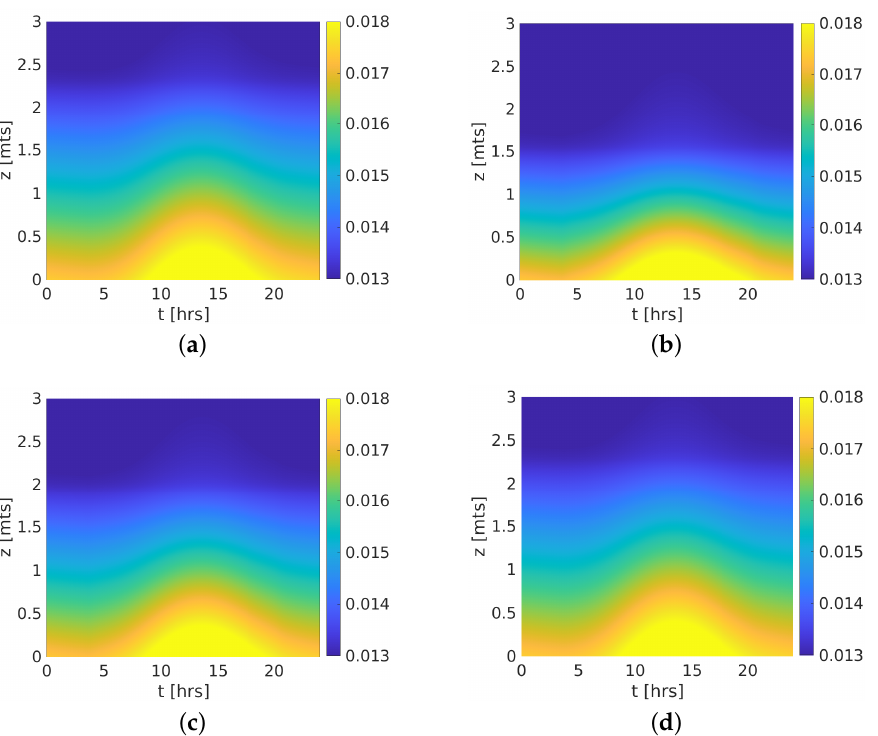
Figure 6. Leaf humidity at 24 h for all canopy shapes. ( a ) Case 1; ( b ) Case 2; ( c ) Case 3; ( d ) Case 4.